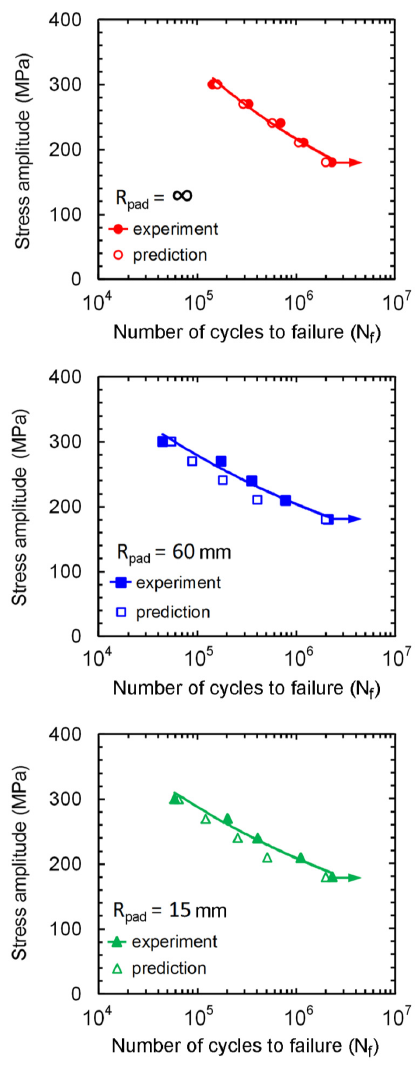
Figure 17. Fretting fatigue lives.